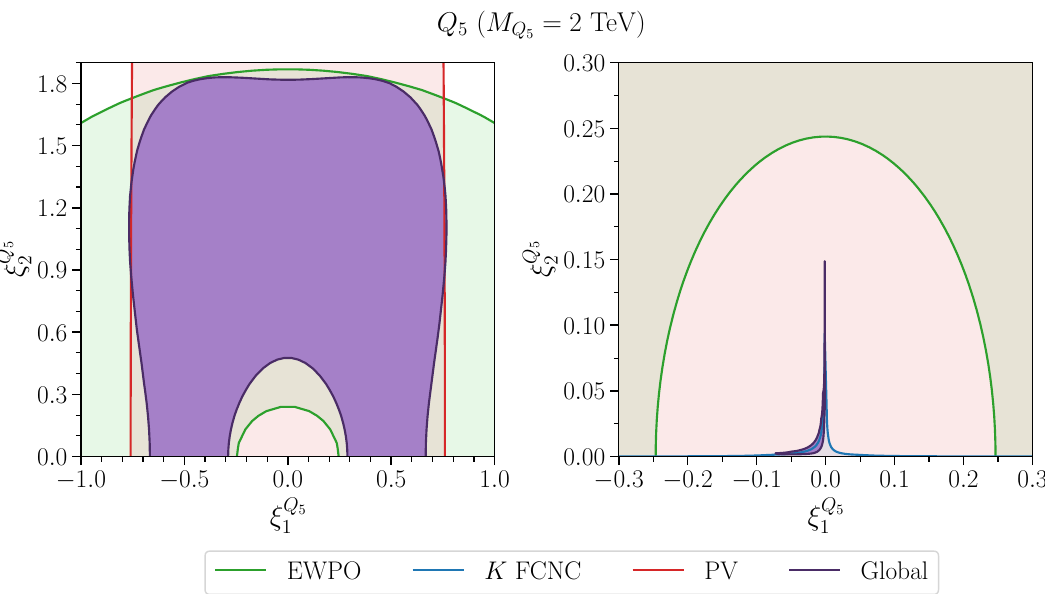
Figure 10 . Global fit to 1 st and 2 st generation couplings of the VLQ Q 5 . The left-hand side assumes multiple generations of VLQs, each only coupling to a single generation (i.e. effectively removing constraints from kaon physics), while on the right side this assumption is